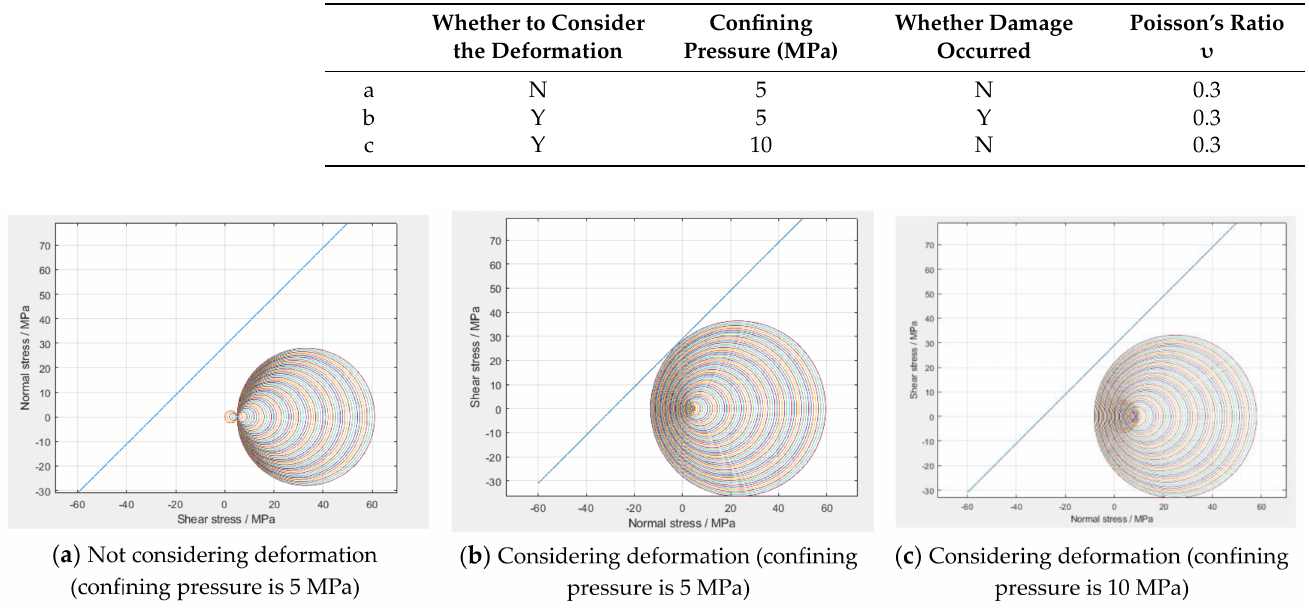
Table 1. Simulation parameter table.